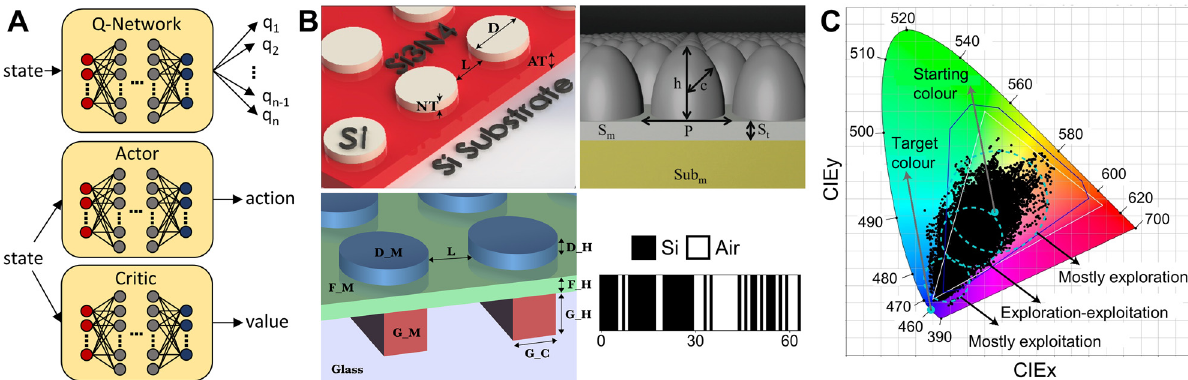
Figure 13: Use of reinforcement learning frameworks in nanophotonic device designs. ( A ) Two most widely used frameworks of deep RL. The top fi gure is value-based q-learning which uses a neural network to approximate the q function. This structure is suitable for discrete fi nite action space and chooses action according to the q values of the state-action pairs. The bottom fi gurerepresentstheactor-criticframeworkinwhichtwodifferentneuralnetworksareusedto approximateanactoranda critic.Critic approximates the state value or the state-action value as the q-network. On the other hand, the actor approximates a policy, which directly mapsthe stateto actionor a probability distribution over theaction space. ( B ) Different parameterizations of the devicesoptimizedin eachof the RL methods [193 – 196]. B (Up-left) adapted with permission from [193]. Copyright 2019, Optical Society of America. B (Up-right): Adapted with permission from [195]. Copyright 2020, Royal Society of chemistry. B (Down-left) adapted with permission from [194]. Licensed under CC BY 4.0. (Down-right) Adapted with permission from [196]. Licensed under CC BY 4.0. ( C ) A progression of optimization from Ref. [193] that shows how an RL agent typically behaves during optimization. Initially, the agent explores, covering a large search space. As the learning progresses, the agent explores less and exploits more, converging to the optimum. C adapted with permission from [193]. Copyright 2019, Optical Society of